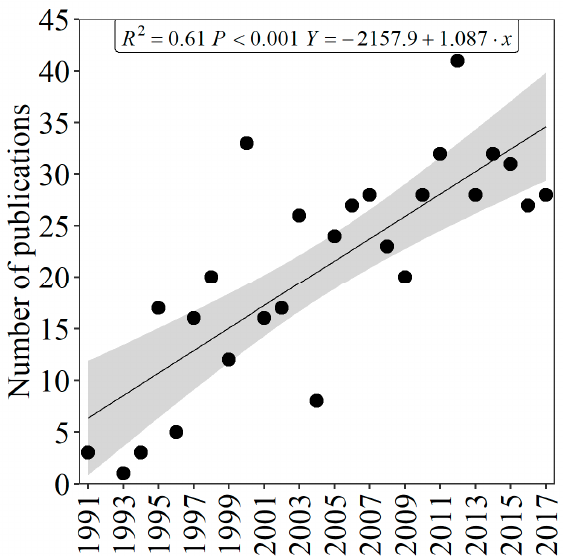
Figure 1. Number of publications about mercury in the Amazon between the years 1991 and 2017.